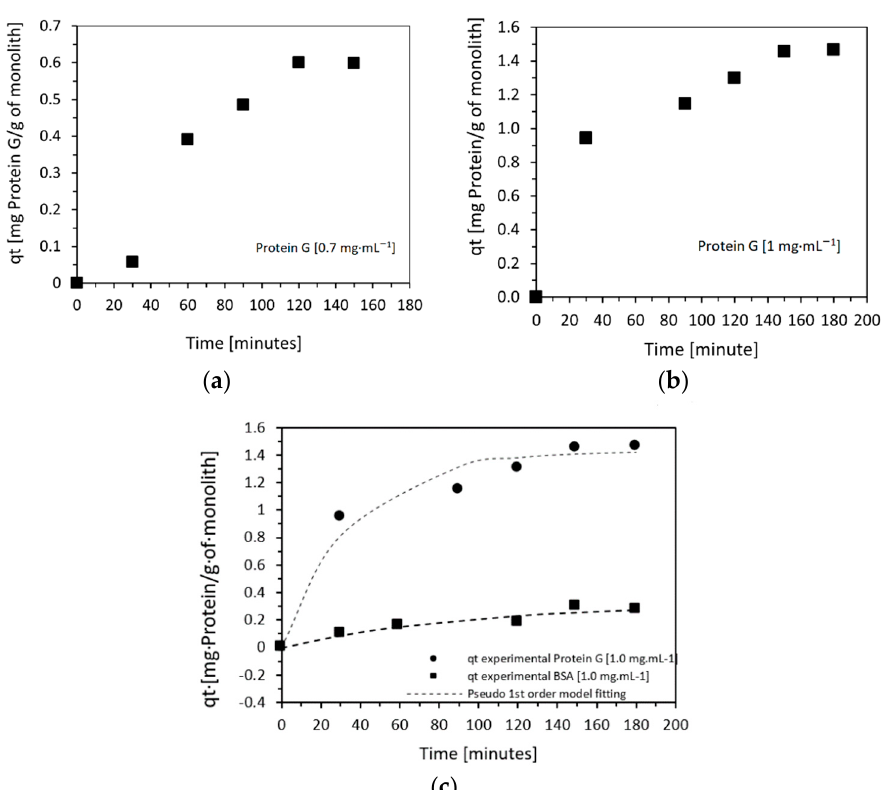
Figure 4. Amount of Protein G, qt (mg Protein G/g monolith) attached to the amine-functionalized monolith column as a function of time using initial Protein G concentrations of ( a ) 0.7 mg·mL − 1 and ( b ) 1.0 mg·mL − 1 . ( c ) Amounts of protein G and BSA, qt (mg of protein/g of monolith) attached to the amine-functionalized monolith column as a function of time, using initial protein concentrations of 1 mg·mL − 1.